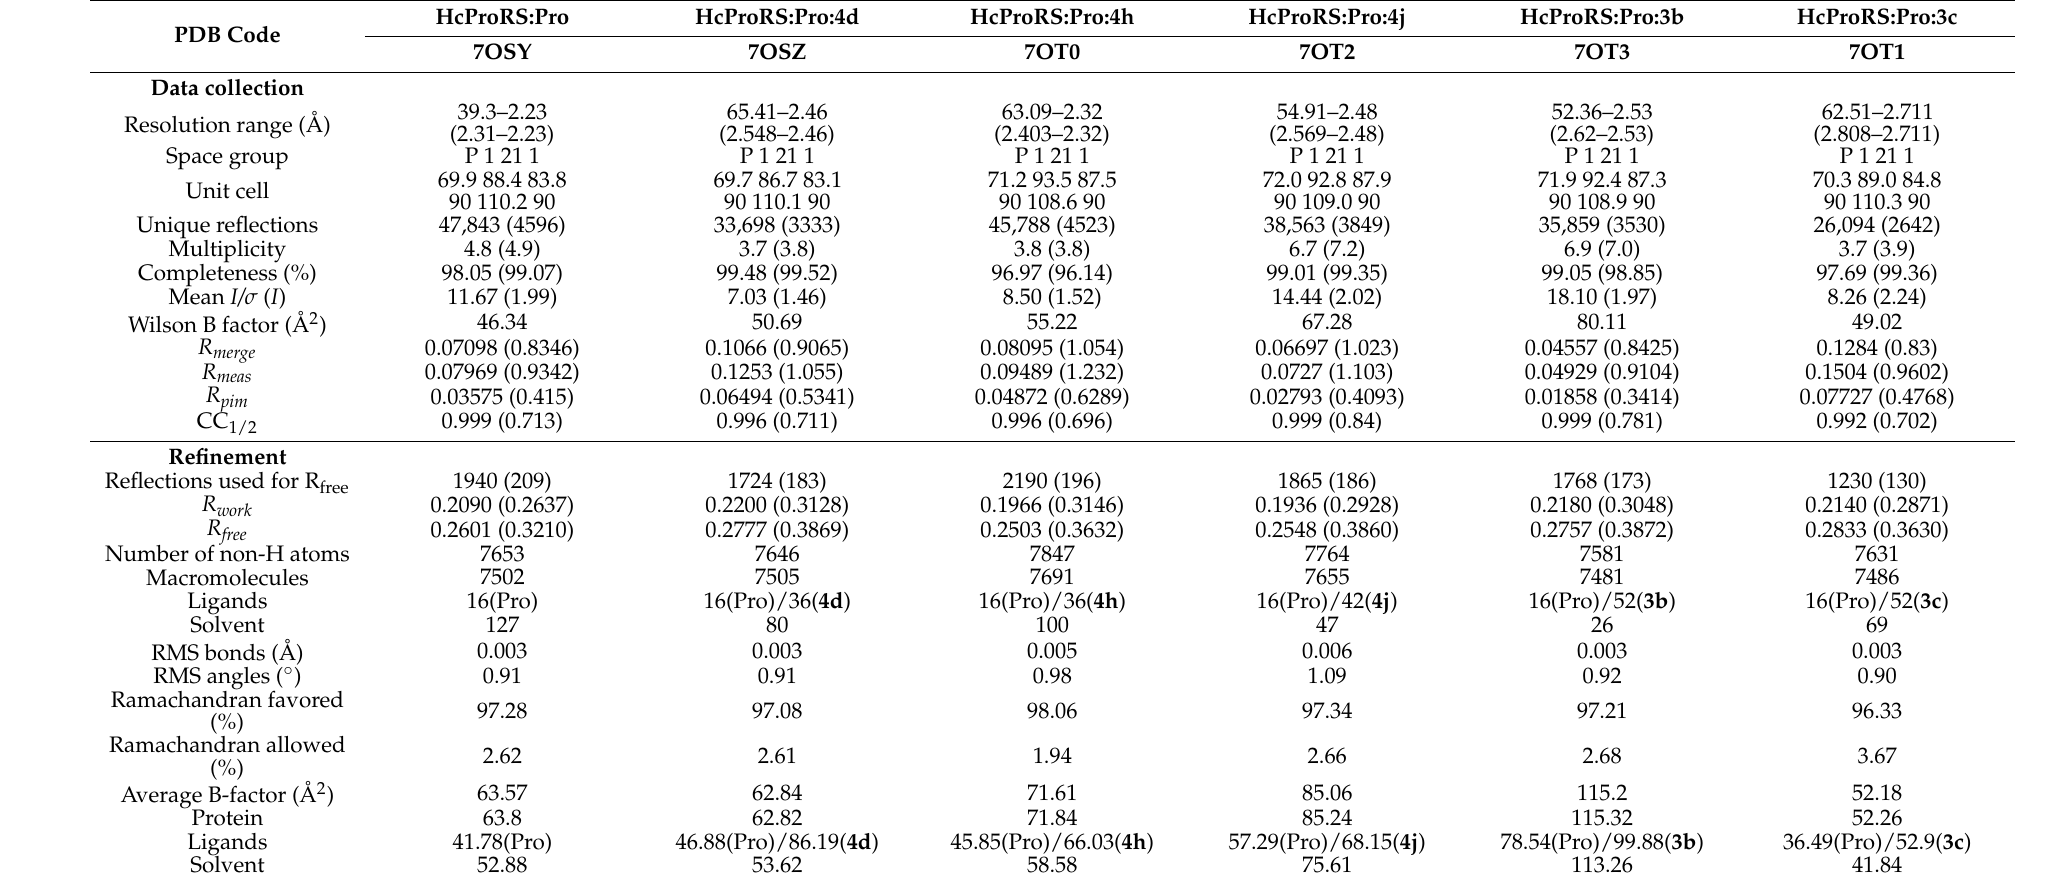
Table 2. Data collection and refinement statistics for the structures of HcProRS